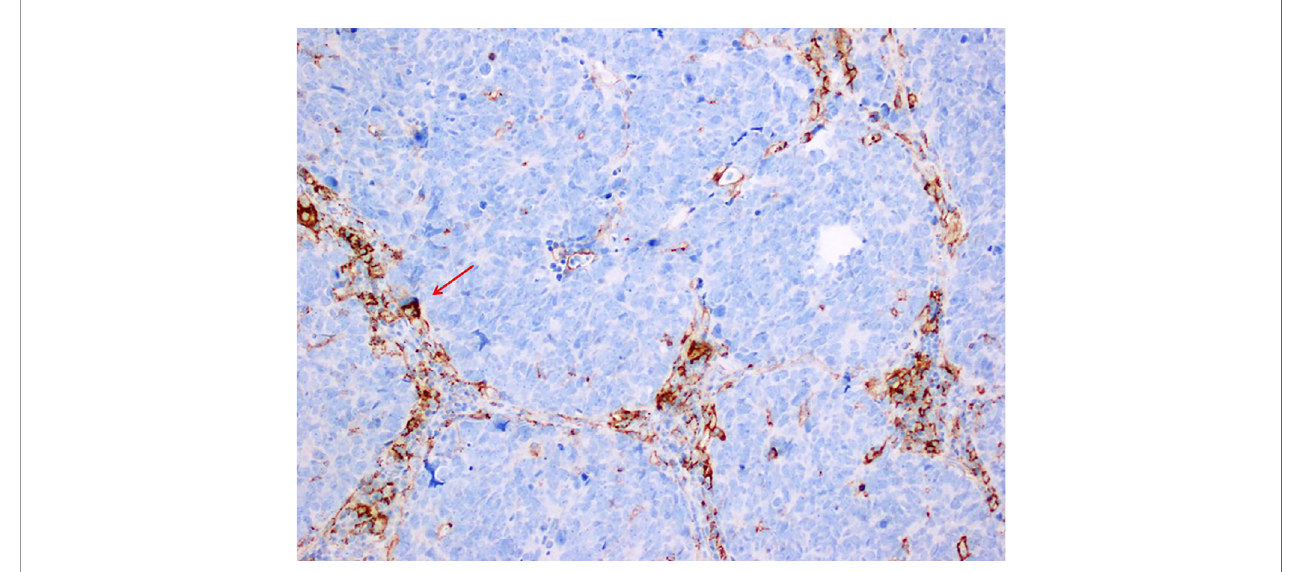
FIGURE 1 | Immunohistochemistry stain, antibody anti PD-L1, SP263 VENTANA 200X MAGNIFICATION in a case of Small Cell Lung Carcinoma. PD-L1 positivity is limited to tumor in fi ltrating lymphocytes that lie between the nest of tumor cells, that are negative to